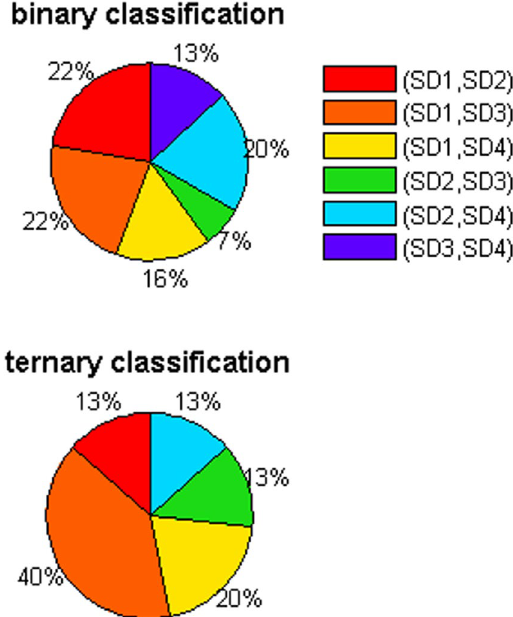
Figure 8. Selection frequency of multi-distance SD separations representing the highest classification accuracy in Figure